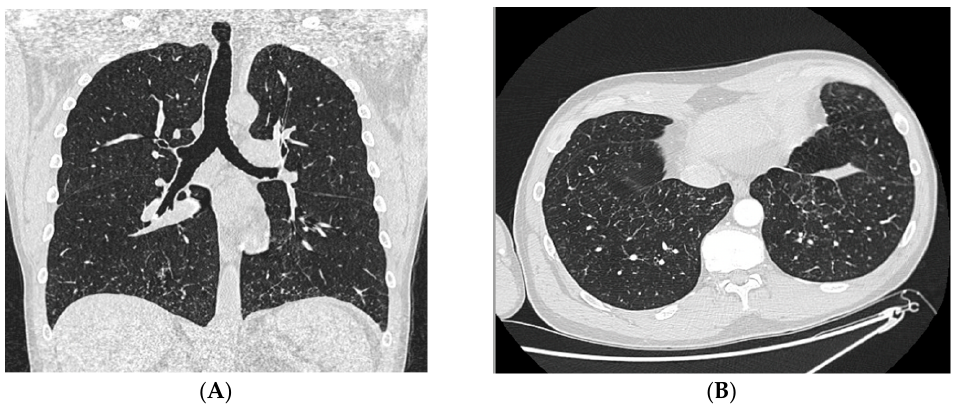
Figure 3. ( A ) HRCT coronal and ( B ) axial reconstructions demonstrating mild smooth thickening of the interlobular lung interstitium and the presence of many micronodules, especially in the basal sectors of the lower lobes.